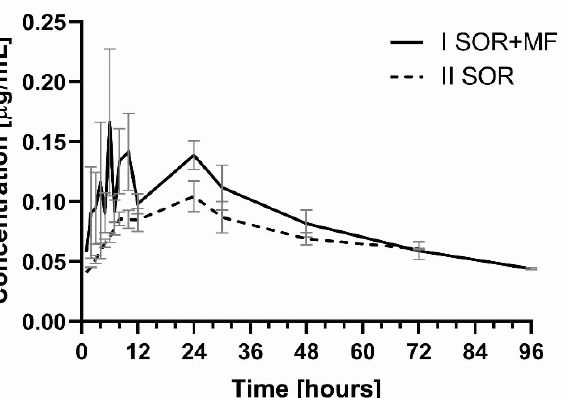
Figure 2. The sorafenib N-oxide plasma concentration–time profiles in rats receiving sorafenib (II SOR ) and sorafenib + morphine (I SOR+MF